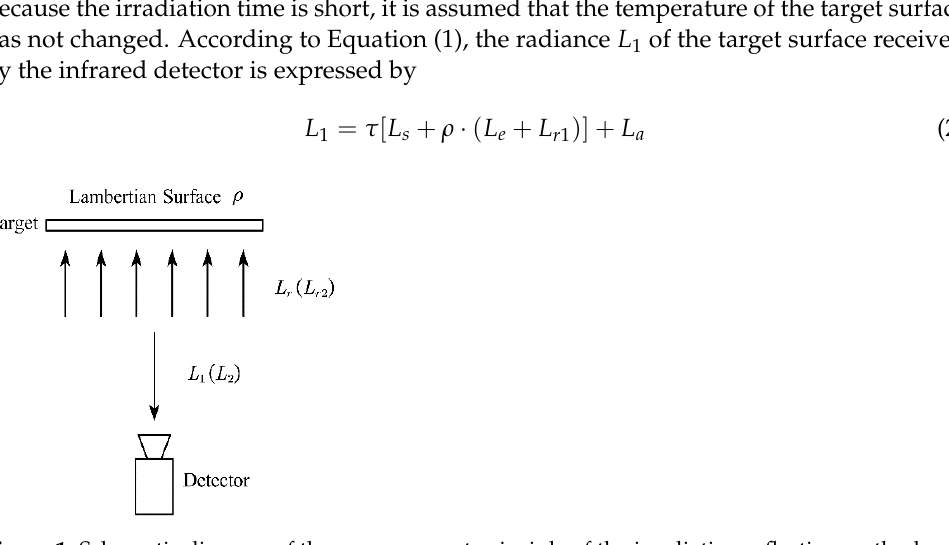
Figure 1. Schematic diagram of the measurement principle of the irradiation reflection method.